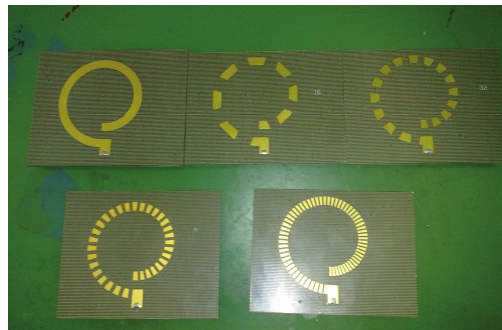
Figure 3: Photograph of these five antennas.